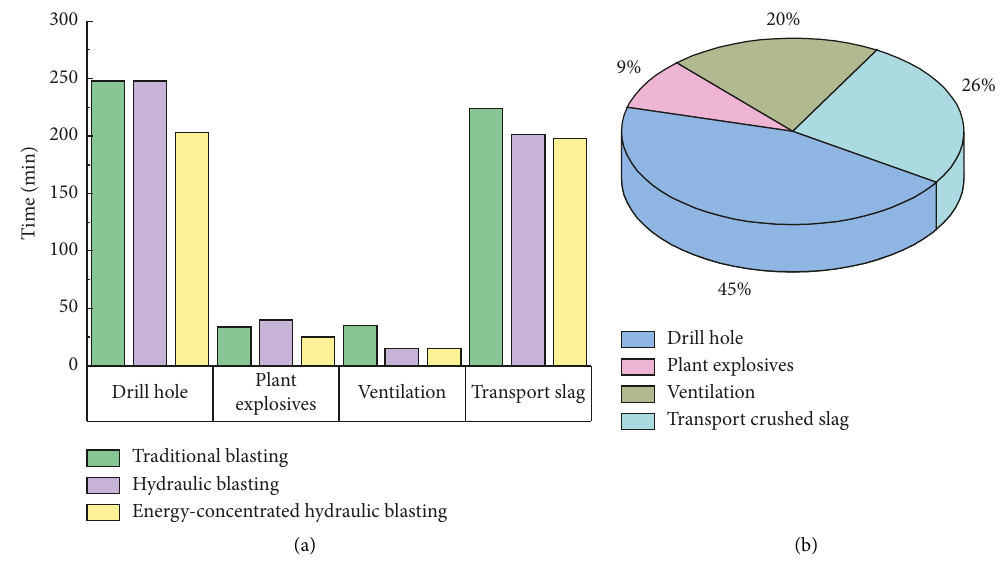
Figure 10: Time-saving statistics. (a) The process time of different technologies. (b) The proportion of time saved by ECHBTcompared with conventional blasting technology